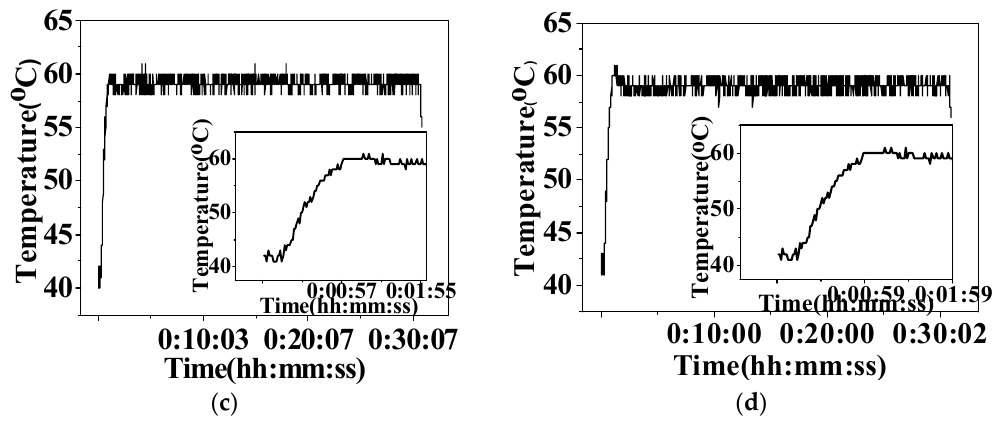
Figure 1. Reaction profile of arene Ru(II) complexes in dichloromethane irradiated by microwave for 30 min at 60 °C. ( a ) 1b ; ( b ) 2b ; ( c ) 3b ; ( d ) 4b . Table 1. Yields of arene Ru(II) complexes by microwave-assisted and conventional synthesis methods. Complexes Microwave-Assisted Conventional Temperature/°C Time/h Yield/% Temperature/°C Time/h Yield/%